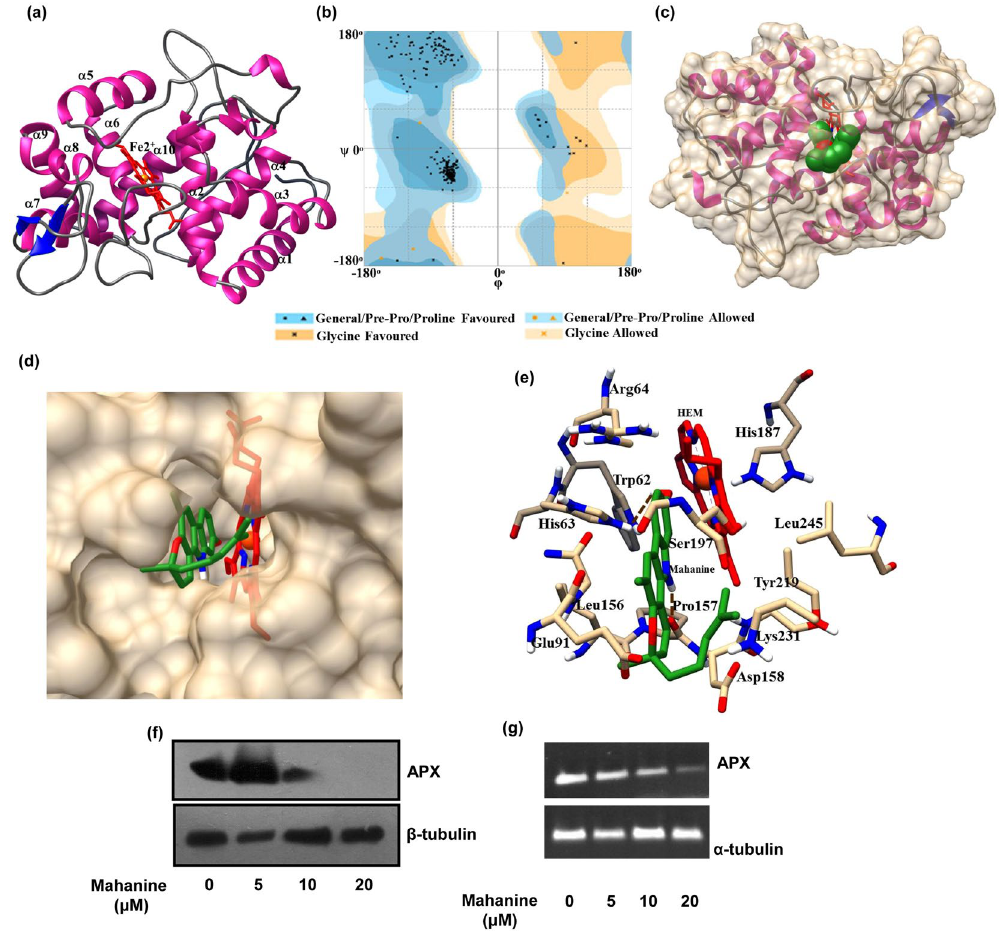
Figure 4. Molecular modeling, genetic and protein level expression profile of ascorbate peroxidase (APX) of L. donovani with mahanine. ( a ) Modeled structure of L. donovani APX with bound HEM group in the active site. The structure is displayed in ribbon form where colours are represented as (sheets = dark blue, helices = magenta and loop = grey). HEM moiety is represented in sticks in red color and Fe 2 + in orange. ( b ) Ramachandran plot of the modeled structure. ( c ) Docked complex of mahanine with ascorbate peroxidase. The ligand is represented in sphere form where C = green, O = red, N = blue and H = white. The protein is represented both as a partial Connolly surface in tan color and ribbon form with helices (magenta) and sheets (dark blue). ( d ) Close view of mahanine bound in the active site of the enzyme; mahanine is in close proximity to the HEM. Mahanine and HEM are represented in stick model. ( e ) Amino acid residues of ascorbate peroxidase interacting with mahanine involving H-bond and van der Waals interactions. Both residues and the ligand represented as stick model where colors are highlighted as [carbon (APX) = tan, carbon (mahanine) = green, carbon (HEM) = red, oxygen = red, nitrogen = dark blue, Fe 2 + = orange]. ( f ) The cell lysate was prepared from mahanine (0–20 µ M)-treated log phase promastigotes (2 × 10 7 ) for 24 hr and run in SDS-PAGE (12%). The blot was incubated with antibody against ascorbate peroxidase and β -tubulin and developed similarly. ( g ) Promastigotes were treated similarly as stated above and total RNA was isolated. cDNA was prepared, PCR performed using a specific primer of APX and α -tubulin and run in a gel. The image was visualized and photographed in Bio-Rad Gel Documentation